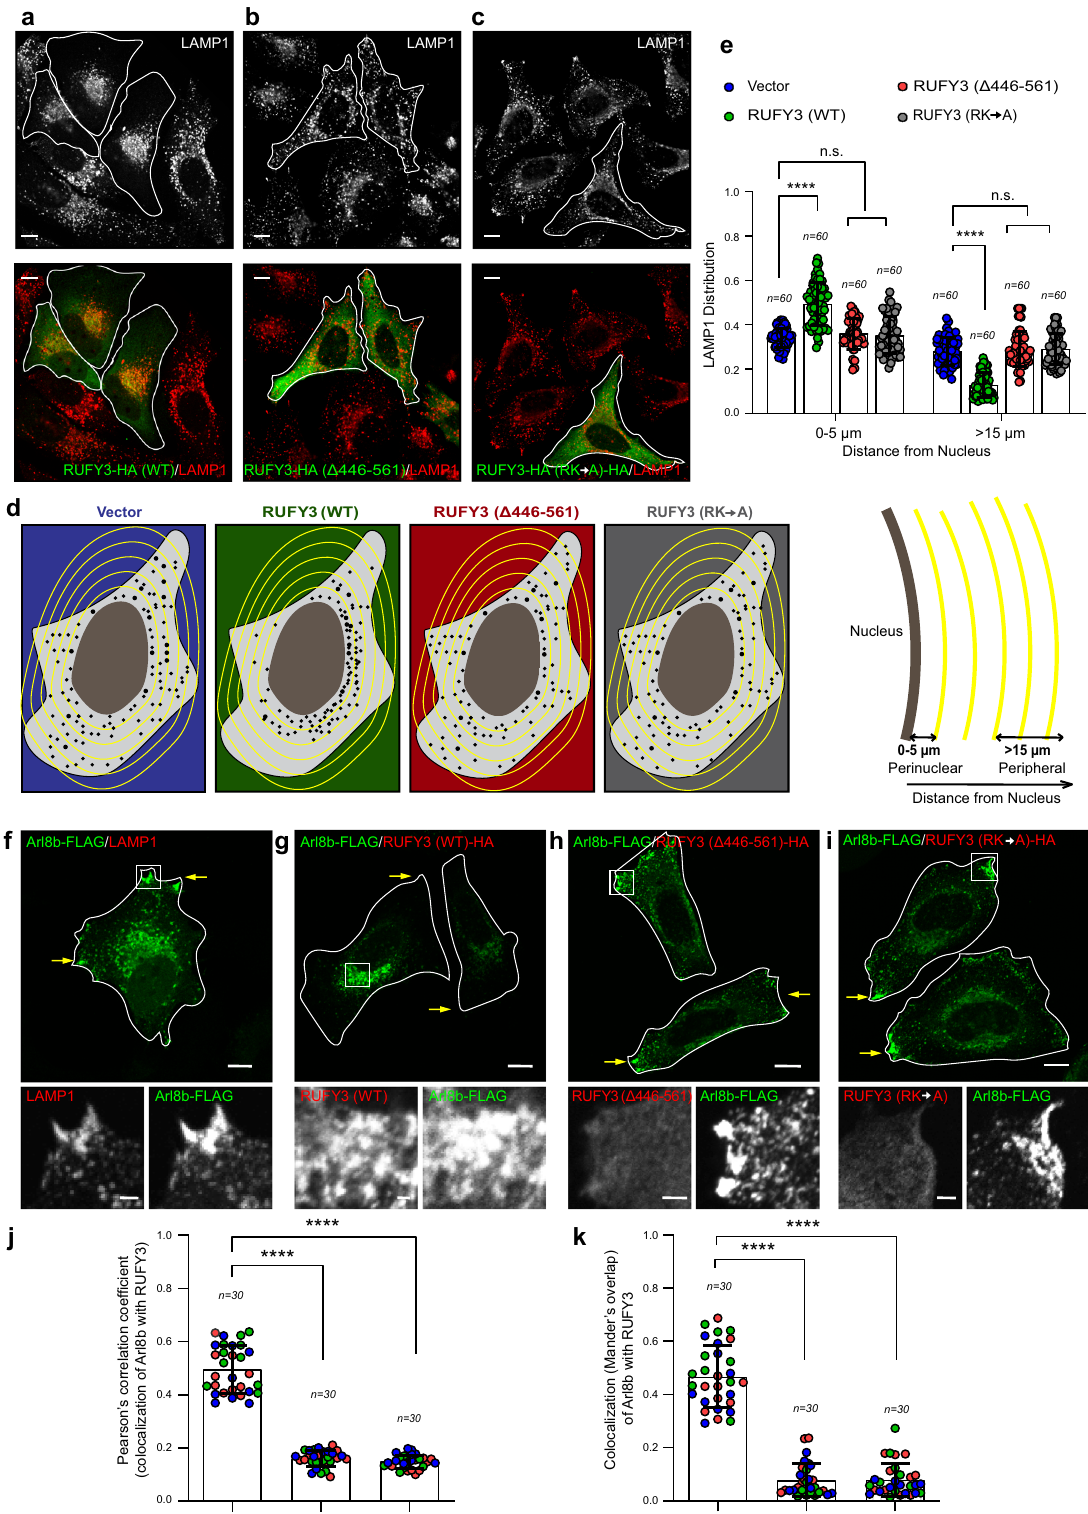
constructs. As shown in Fig. 2e and Supplementary Fig. 2m, the distribution of lysosomes in RUFY3 (WT) transfected cells was signi fi cantly shifted to the perinuclear region and away from the periphery. Importantly, RUFY3 mutant proteins defective in binding to Arl8b (i.e., RUFY3 ( Δ 446 – 561) and RUFY3 (RK → A)) did not localize to the LAMP1 compartment or